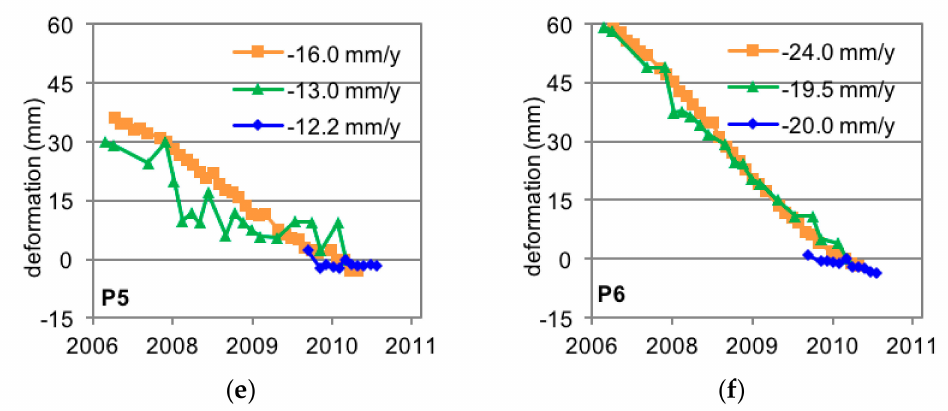
Figure 7. Time series displacements at six typical CPs: ( a ) P1, ( b ) P2, ( c ) P3, ( d ) P4, ( e ) P5, and ( f ) P6 derived from ASAR, PALSAR, and TerraSAR-X data stacks.